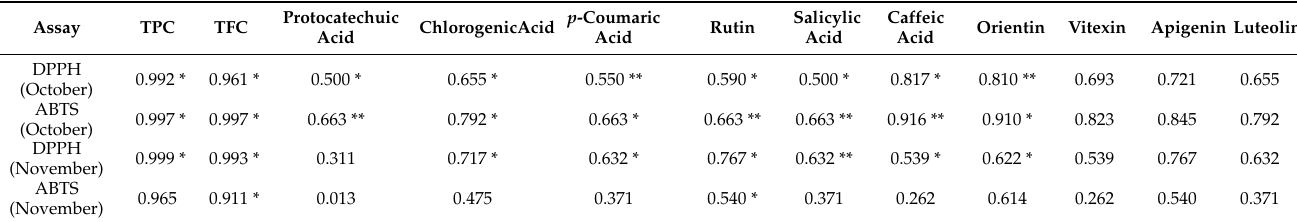
Table 2. Pearson correlation coefficients between the phenolic compounds and antioxidant activity of A. japonica roots extracts.